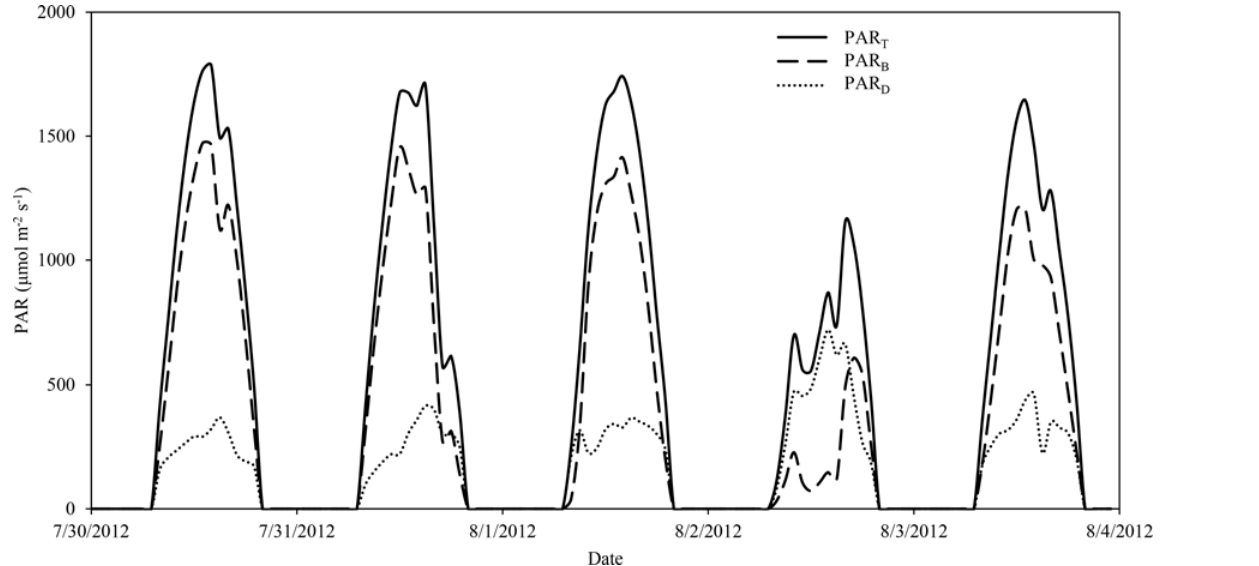
Figure 6. Example time series of radiation